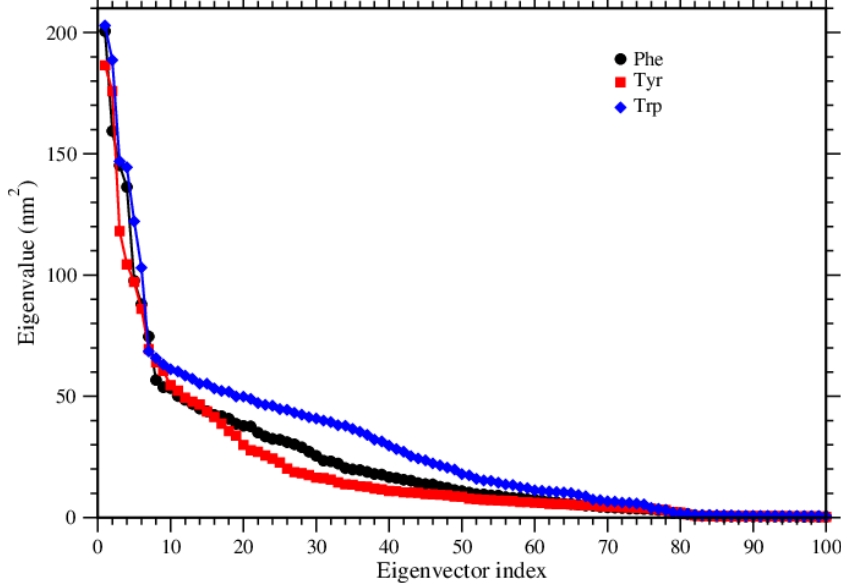
Figure 12. Eigenvalues of the covarience matrix are shown for the three amino